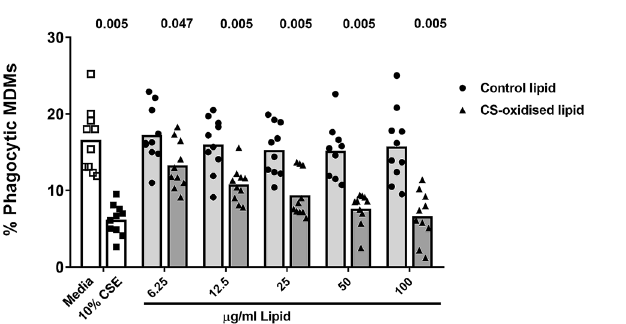
Figure 7. Oxidised epithelial cell lipids inhibit macrophage phagocytic function. MDM were exposed to media with or without cigarette smoke extract (CSE), with varying concentrations of CS-oxidised epithelial lipid (6.25–100 µg/mL) for 24 h, and phagocytosis was measured by flow cytometry. p values vs control provided from Wilcoxon Signed Rank test. n = 10. Data are presented as mean with individual data